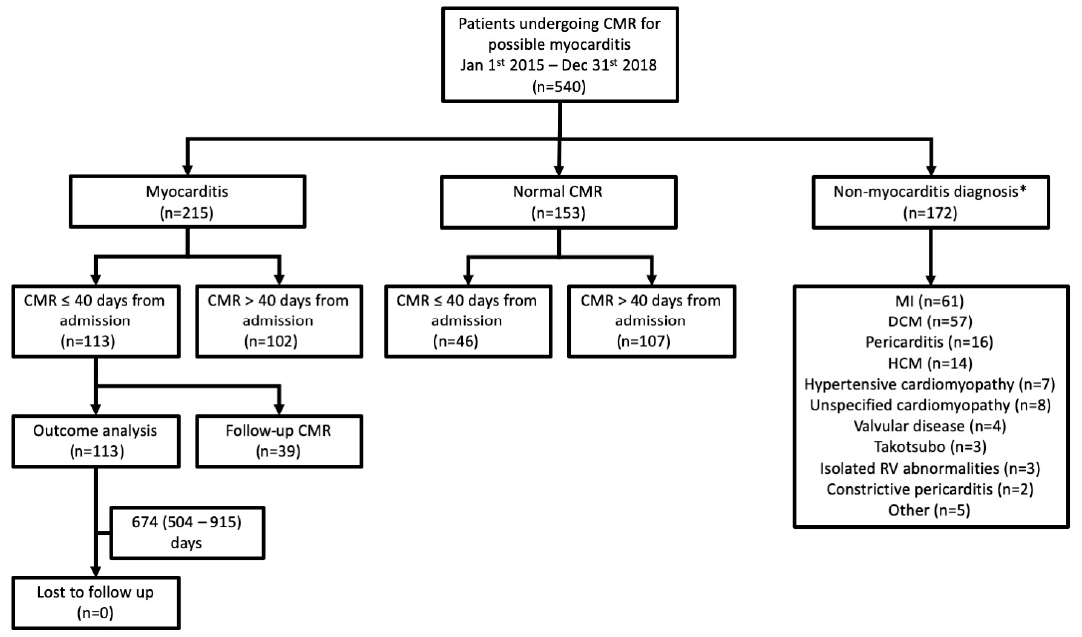
Figure 1. Derivation of the study cohort. CMR-cardiovascular magnetic resonance. * patients could have more than one diagnosis. CMR provided a positive diagnosis in 387 (72%) patients. The most common diagno- ses were myocarditis (215 patients; 40%), myocardial infarction (MI; 61 patients; 11%) and dilated cardiomyopathy (57 patients; 11%).